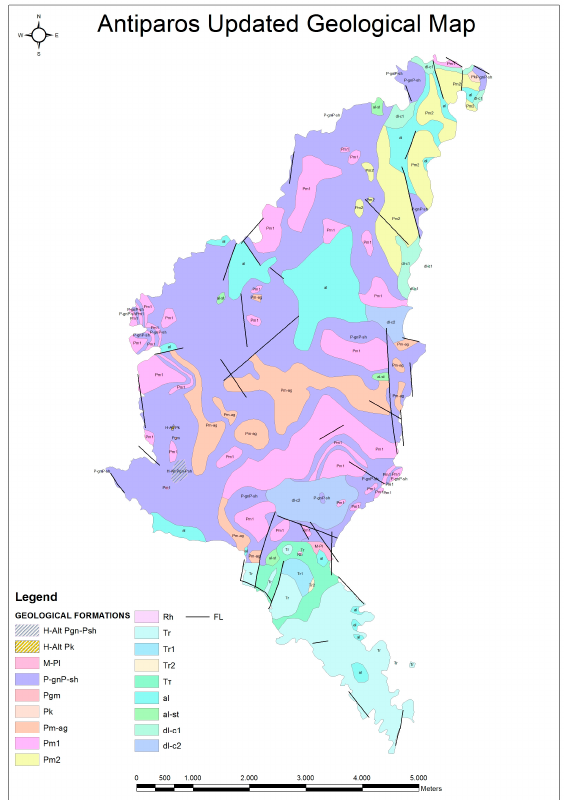
Figure 12. The updated geological map of Antiparos Island at 1/25.000 scale. Abbreviations: H-Alt Pgn-Psh: Hydrothermal altered gneiss to shcist-gneiss, H-Alt Pk: Hydrothermal altered